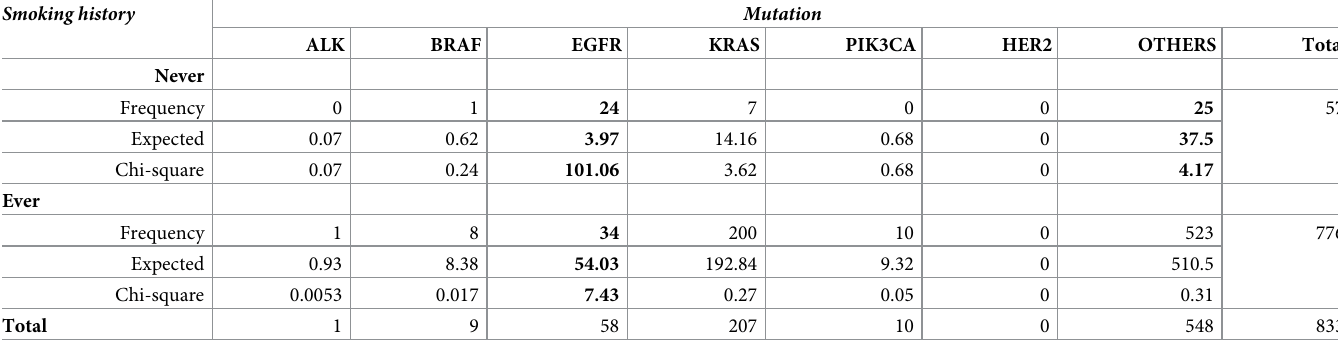
There is strong evidence of an